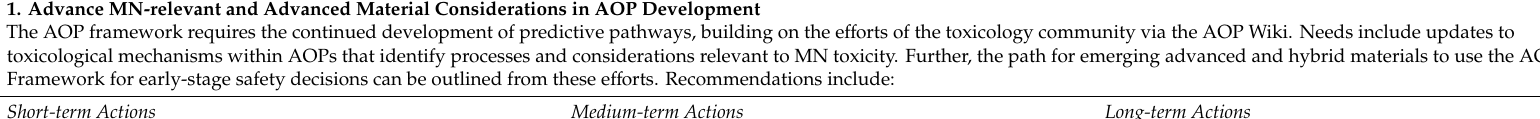
Table 3. Central Recommendations for Promoting the Development, Use and Acceptance of the AOP Framework for MN Decision